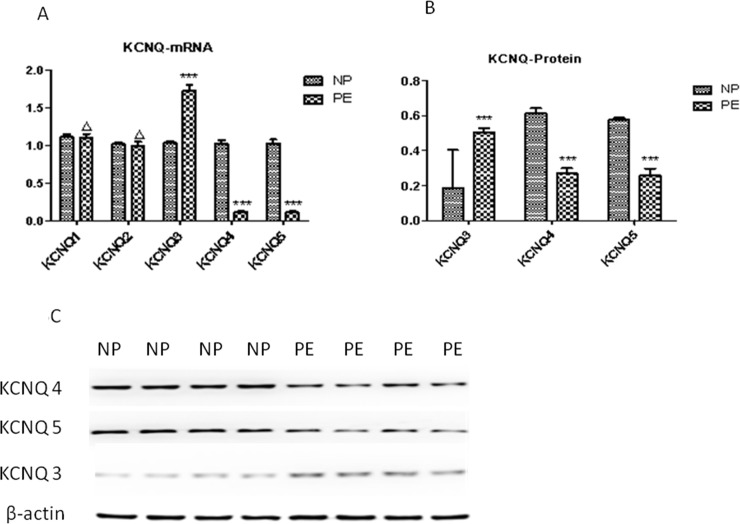
Expression profiles of KCNQ subunits in preeclamptic women compared with normotensive controls.(A) Quantitative polymerase chain reaction analysis of relative abundance of KCNQ genes 1 through 5. Data are normalized to the first normotensive control. (B) Densities of Kv7.3, 7.4, 7.5 bands normalized to their respective β-actin bands. (C).Representative Western blot for Kv7.3, 7.4, and 7.5 expression in total protein lysates run on the same gel. The respective concentrations of protein loaded were identical, as illustrated by theβ-actin bands. ΔP>0.05, ***P<0.001, according to independent-samples t test.